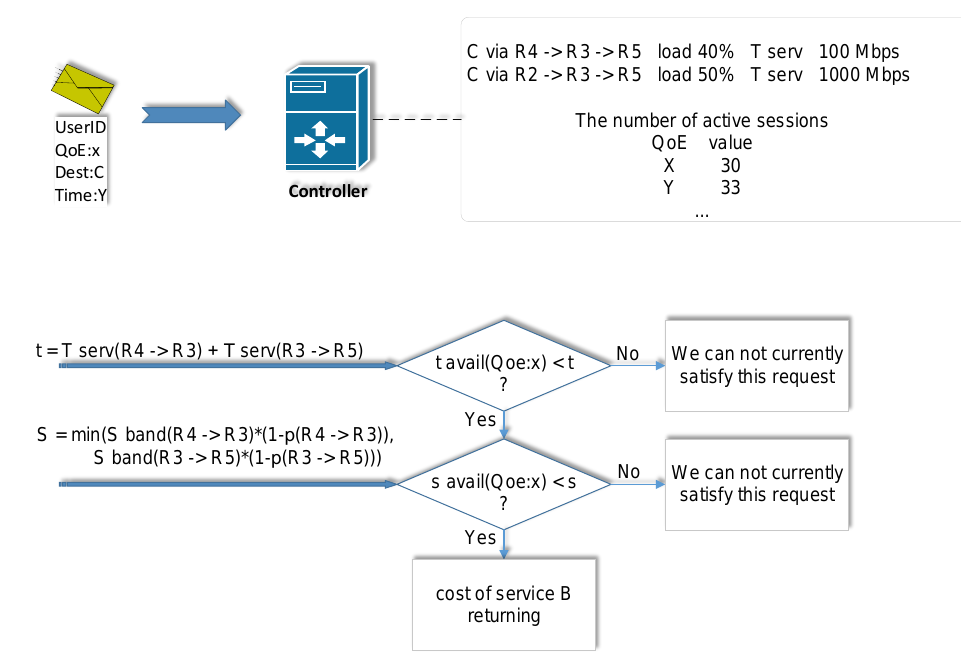
Figure 14. Decision-making algorithm for a new request.